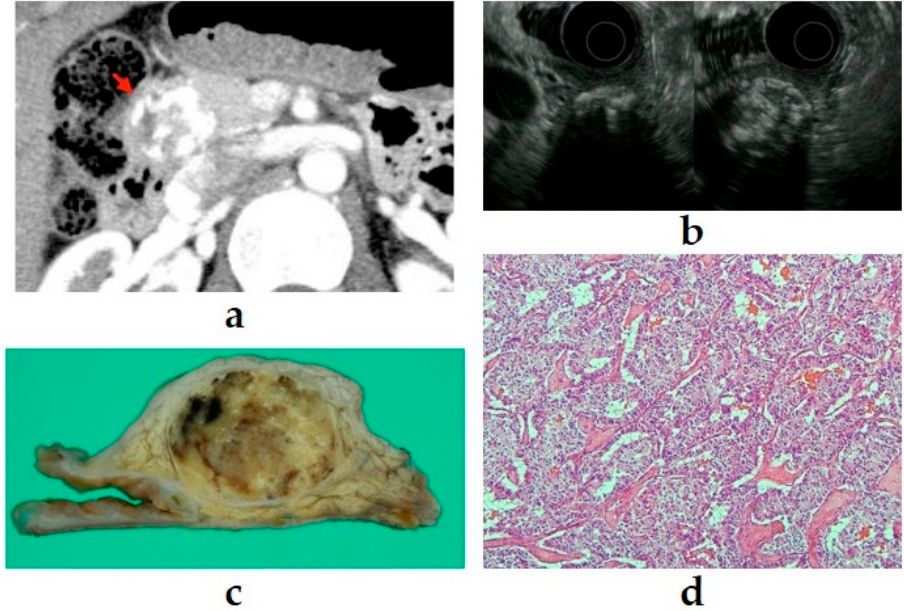
Figure 6. ( a ) Contrast-enhanced computed tomography (CT): a tumor (arrow) with calcification components is shown at the pancreatic head. ( b ) Endoscopic ultrasound (EUS): a well-defined mass with a heterogeneous appearance and peripheral rim calcification with posterior acoustic shadowing. ( c , d ) The imaging findings suggest a solid pseudopapillary neoplasm, but pathologically, it is a neuroendocrine tumor G1 (100×).